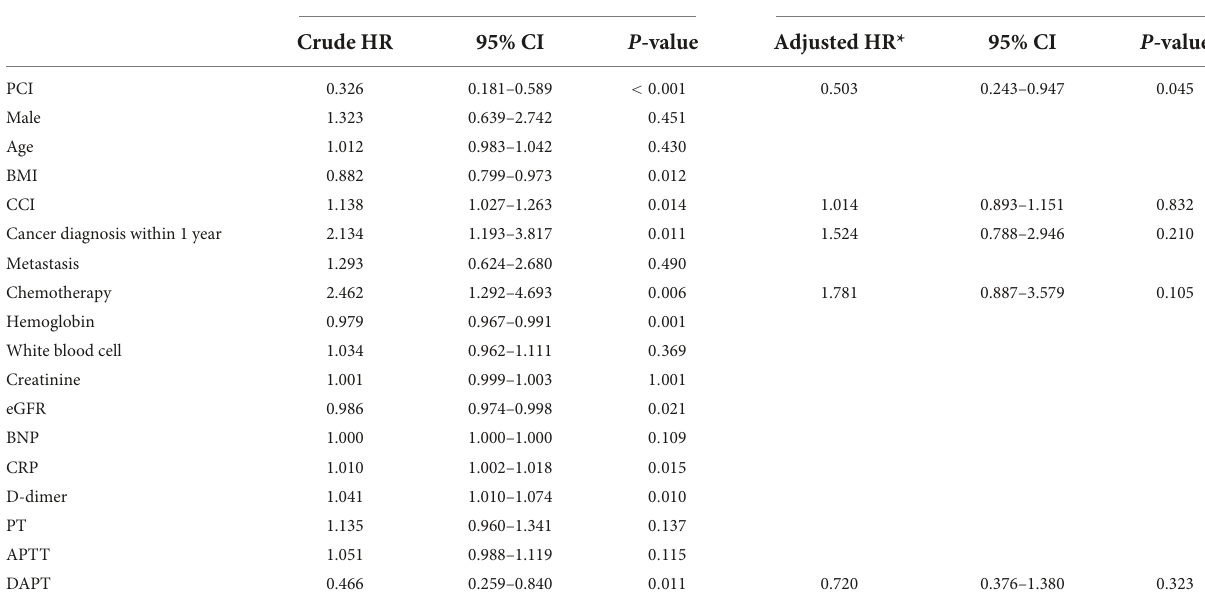
TABLE 3 Univariate and multivariate Cox regression analyses for all-cause mortality. Univariate analysis Multivariate